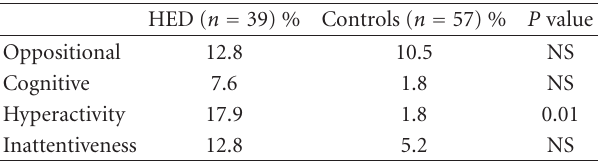
Table 6: Percentage of abnormal T-Scores on CPRS-R:S in children with HED and control